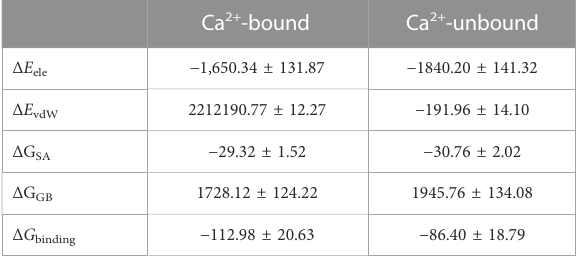
TABLE 1 Binding free energy (kcal/mol) between DAPK1 and CaM in the Ca 2+ -bound and-unbound states. Ca 2+ -bound Ca 2+